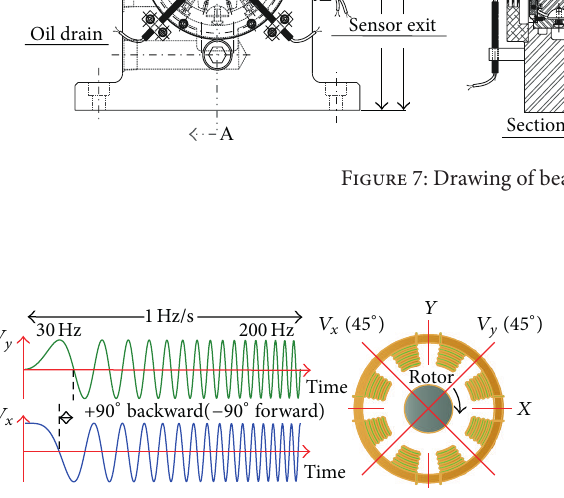
tion. Figure 13 indicates the FRF curve of 𝐻 𝑥𝑥 and 𝐻 𝑥𝑦